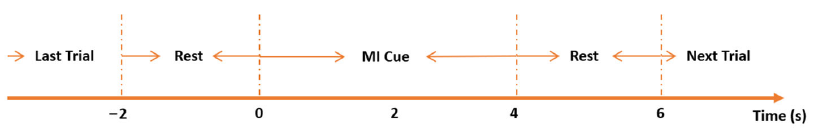
Figure 3. Timing paradigm of the dataset.